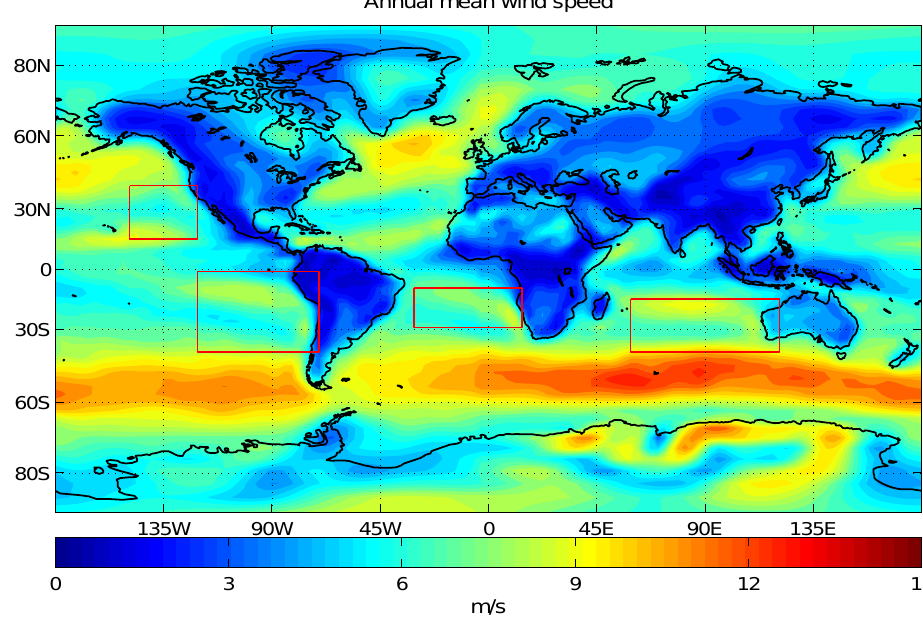
Fig. 4. Annual mean surface wind speed.